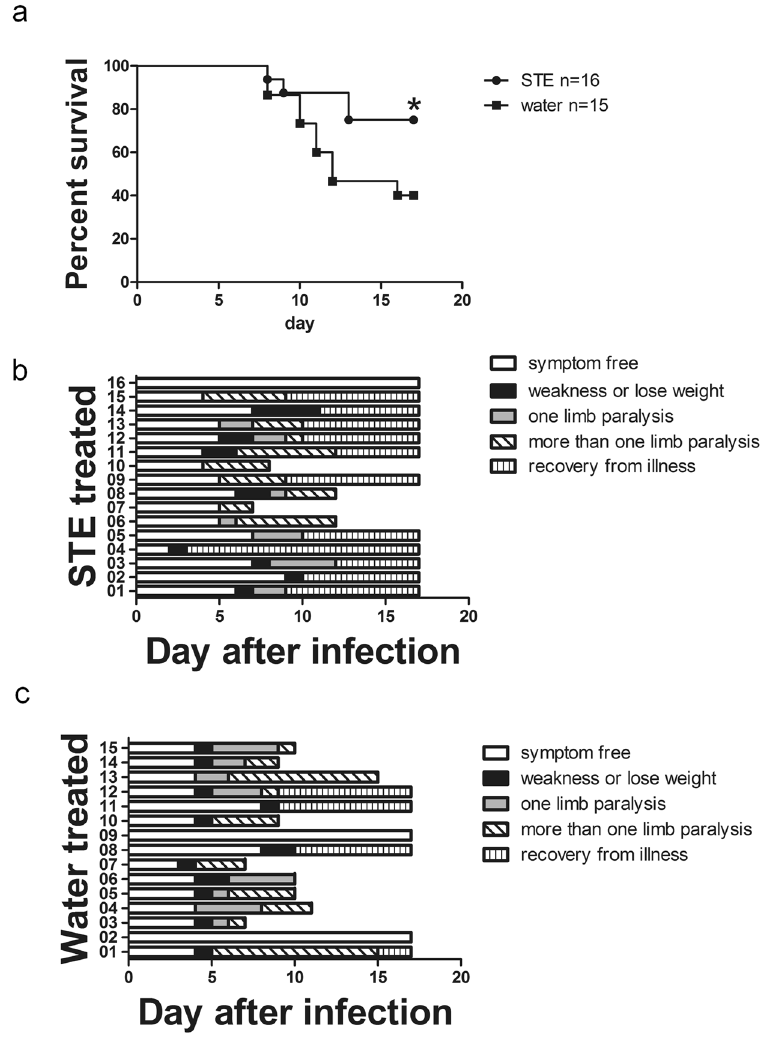
Figure 8. STE alleviates the clinical symptoms of and enhances the survival of EV71 infected mice. ( a ) Seven- day-old ICR mice were intraperitoneally infected with 2 × 10 6 PFU MP4. One day later, EV71-infected mice were treated with single dose of STE (250 mg/kg) (n = 16) or water (10 ml/kg) (n = 15) daily for 14 days. The survival rate ( a ), and clinical symptoms in STE-treated ( b ) or water-treated ( c ) mice were recorded daily for 17 days. The clinical symptoms, including weakness, weight loss, paralysis of one limb, paralysis of more than one limb, and death, were recorded